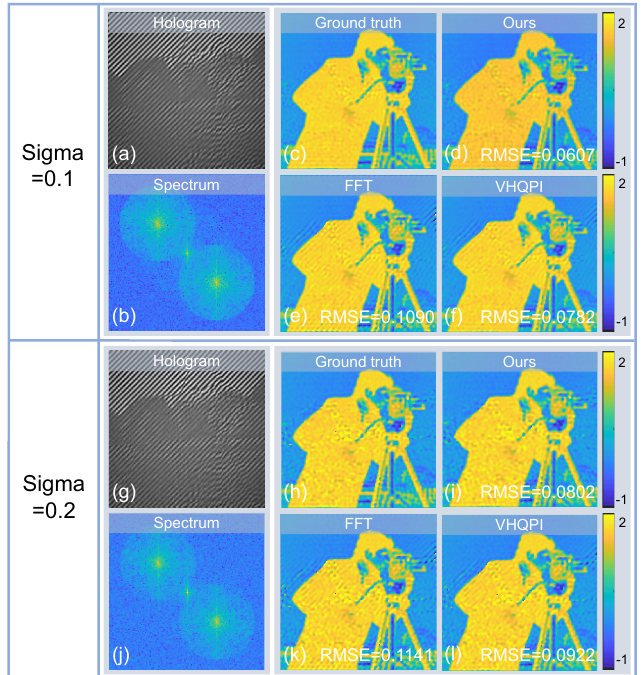
Figure 4. The comparison of phase reconstruction results at noise levels of 0.1 and 0.2, respectively. ( a , g ) The hologram under the noise levels of 0.1 and 0.2. ( b , j ) The corresponding spectrum of ( a , g ). ( c , h ) The ground truth at different noise levels. ( d , i ) The phase results recovered by our method. ( e , f , k , l ) The phase results are reconstructed by the FT method and VHQPI method at the noise level of 0.1 and 0.2,